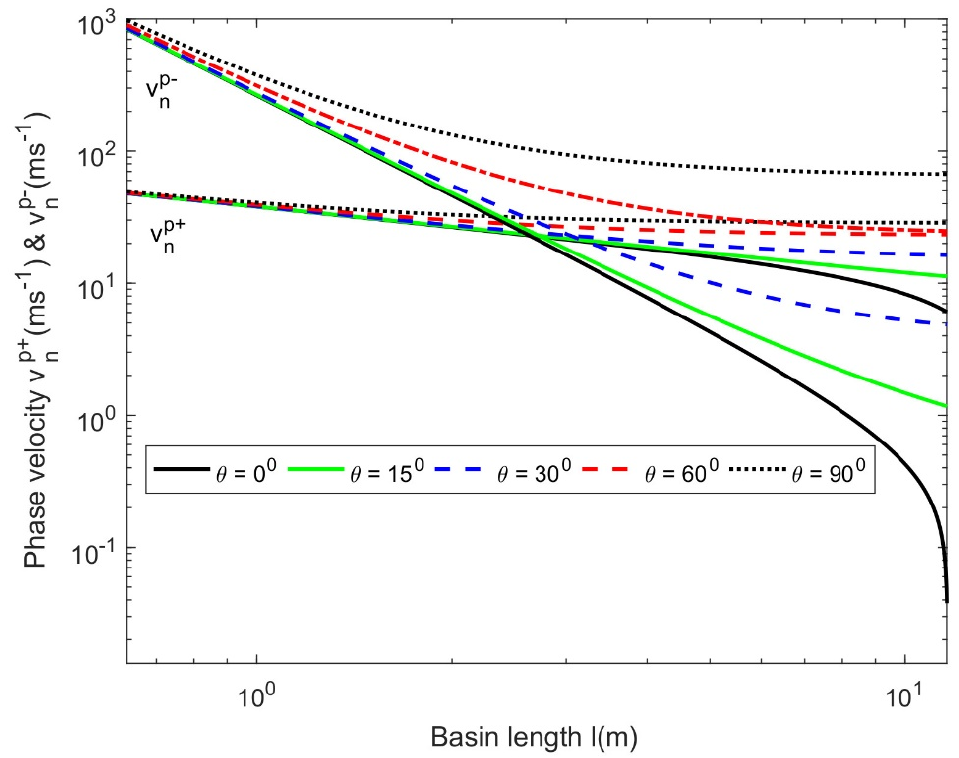
+ θ p p − v + and p v − versus l (m). , on the phase velocity, n and v n versus l (m). n n + g − n and v n , for different θ against l g v − , for different θ against l (m). n